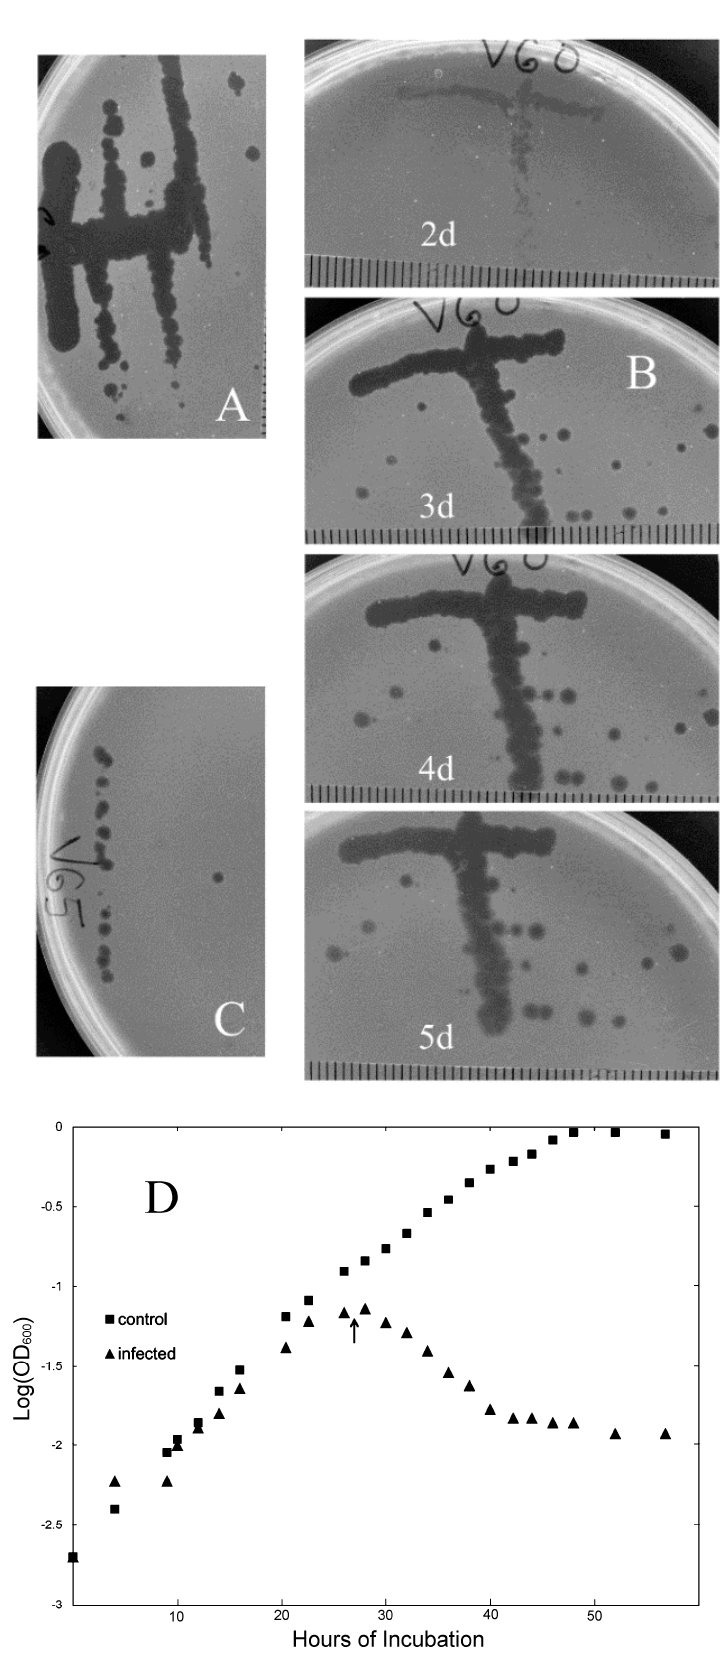
Figure 1. Lytic properties of viral isolates. Panels ( A – C ): Plaque formation. Suspensions of virions were streaked over the surface of overlays containing cells of strain K00 16-4. All photographs